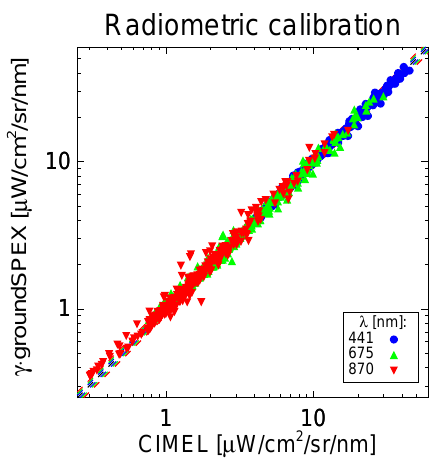
Figure 3. Correlation between sky radiances measured with groundSPEX and the CIMEL sun photometer used for the calibra- tion of the gain γ (λ) of groundSPEX. The dashed lines indicate the combined systematic and random error bars. Note the double logarithmic scale; thus the errors scale with